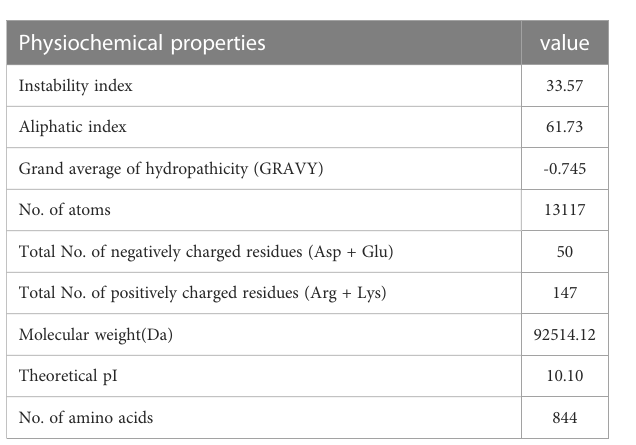
TABLE 9 Analysis of physicochemical properties of the EBV vaccine.